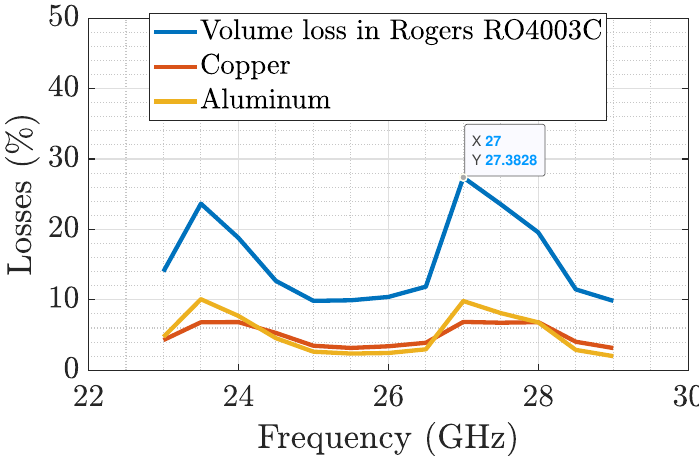
Figure 6. Material losses study as a function of the frequency.